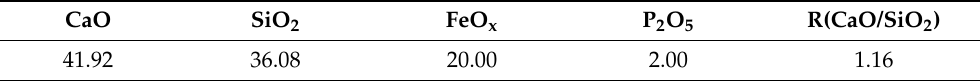
Table 1. Chemical compositions of CaO–SiO 2 –FeO–P 2 O 5 slag